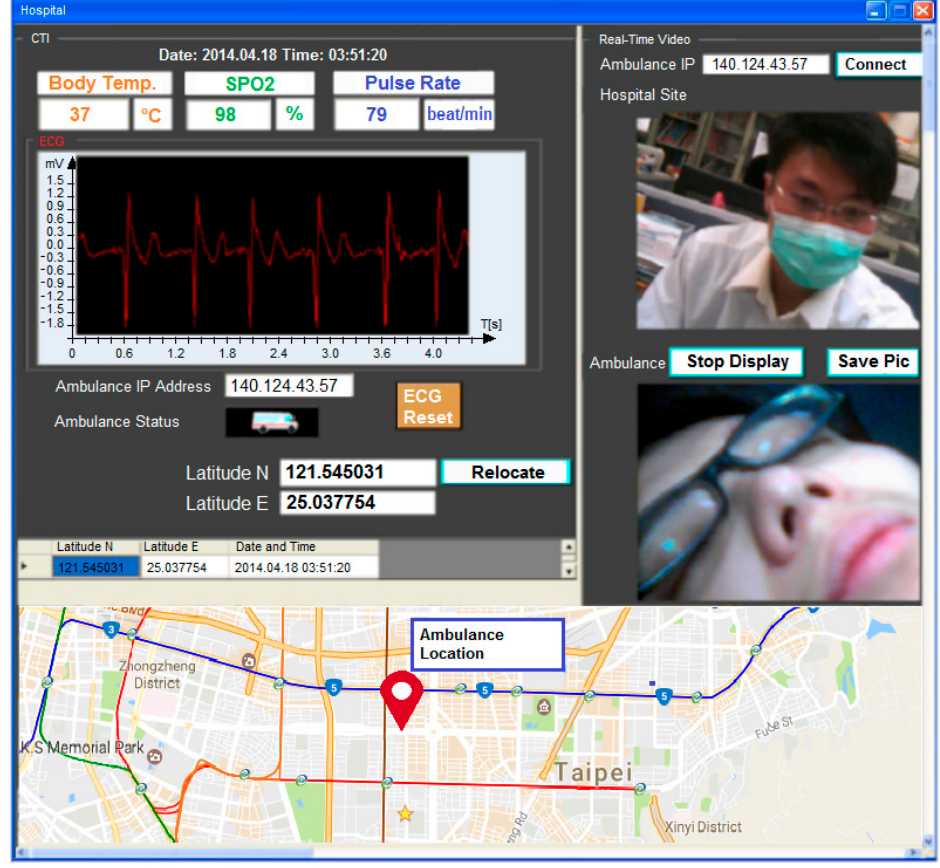
Figure 3. A snapshot of the client tele-diagnosis interface.